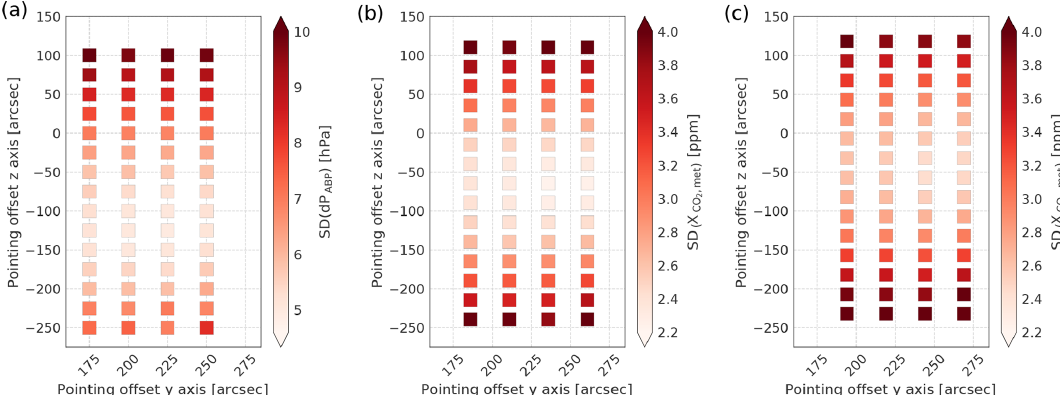
for the weak (b) and strong (c) CO 2 band for FP4 for all 60 geolocation configu- 2 , met